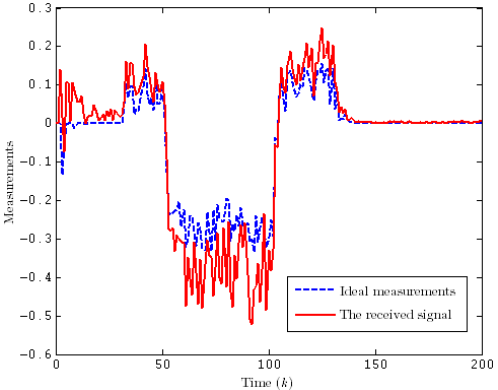
Figure 3. Ideal and practical measurement outputs.